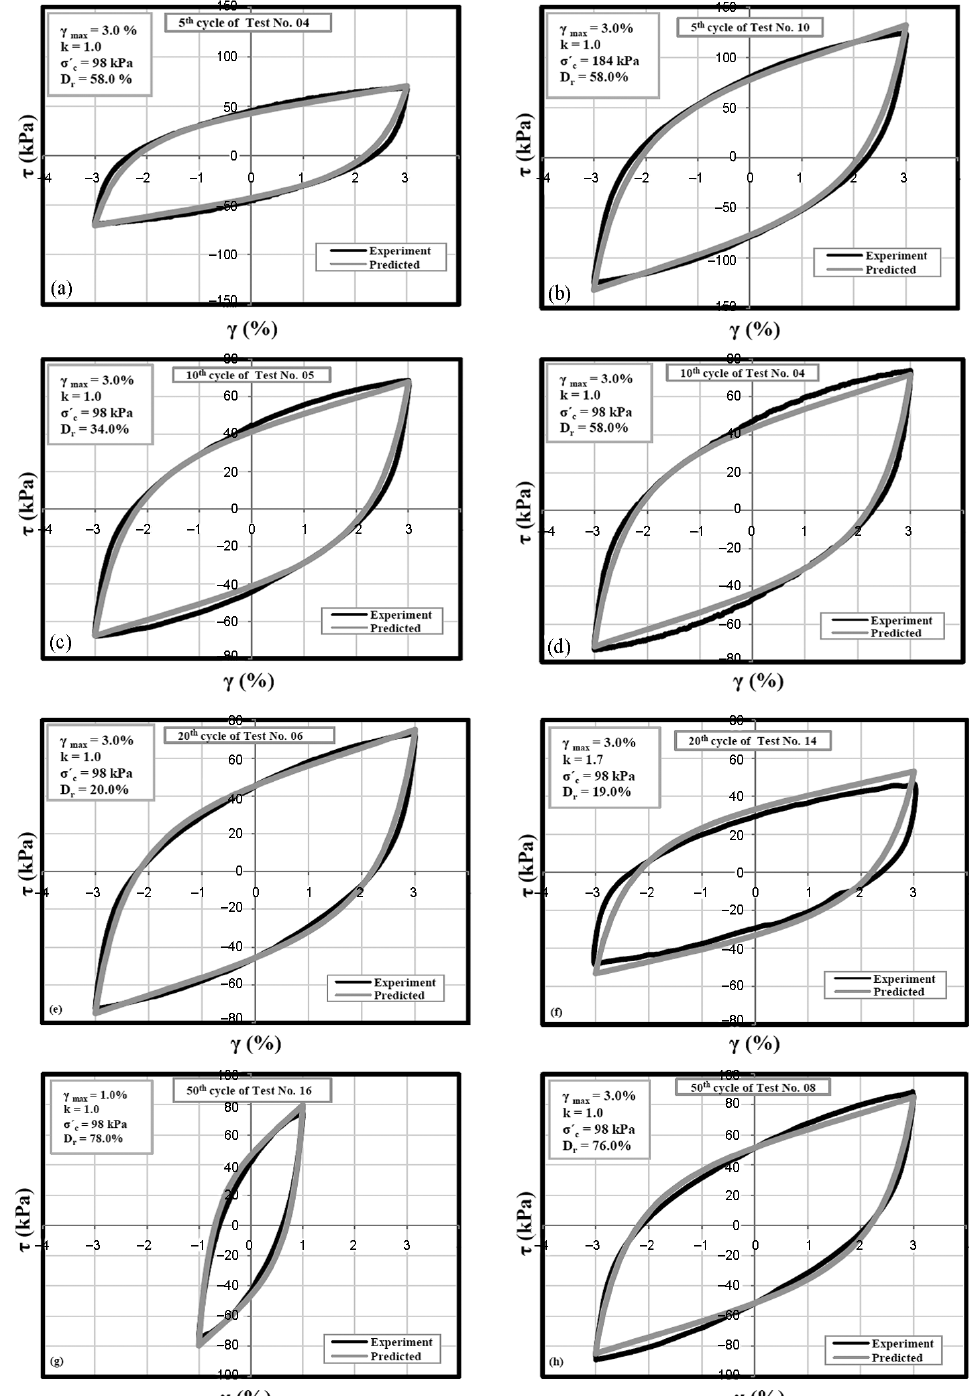
Fig. 8. Experimental hysteresis curves versus predicted